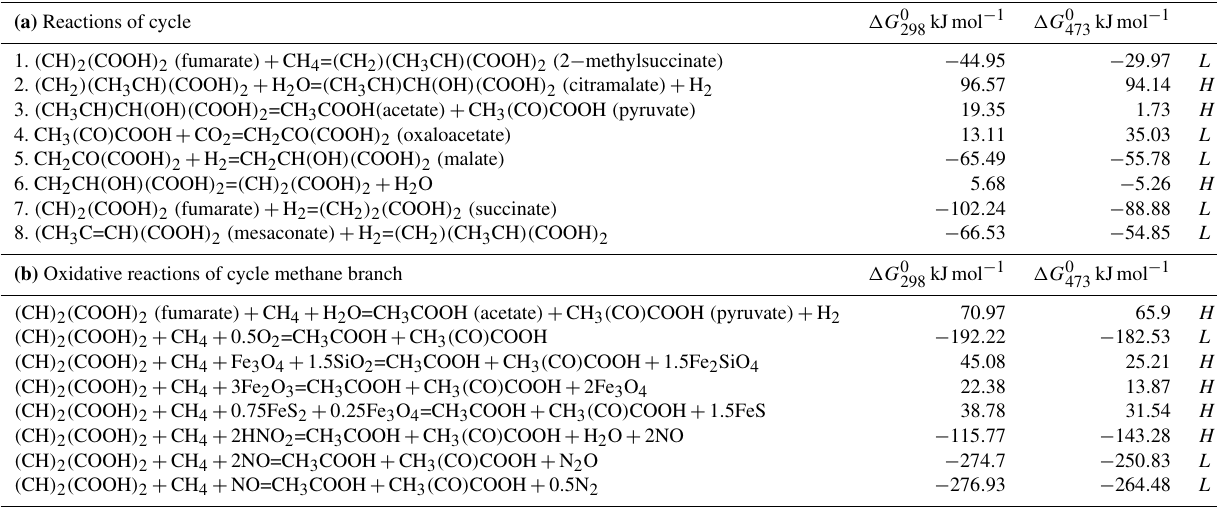
Table 2. The free energy of reactions of MF cycle (a) and reactions of its anaerobic oxidative branch (b) with different oxidants at 298 and 473K and P SAT . Free energies of aqueous substances formation at P SAT (Amend and Shock, 2001; Marakushev and Belonogova, 2012, 2013) were used in